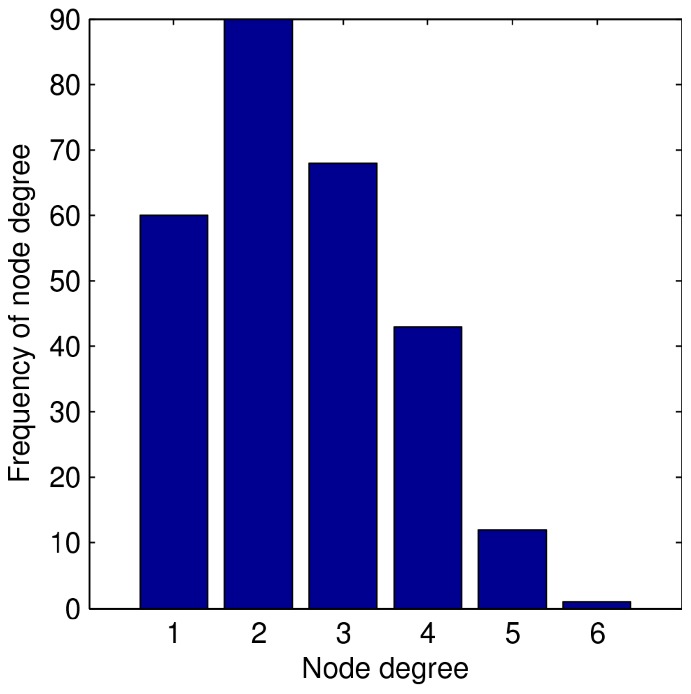
Histogram of node degree for the network shown in Figure 1.